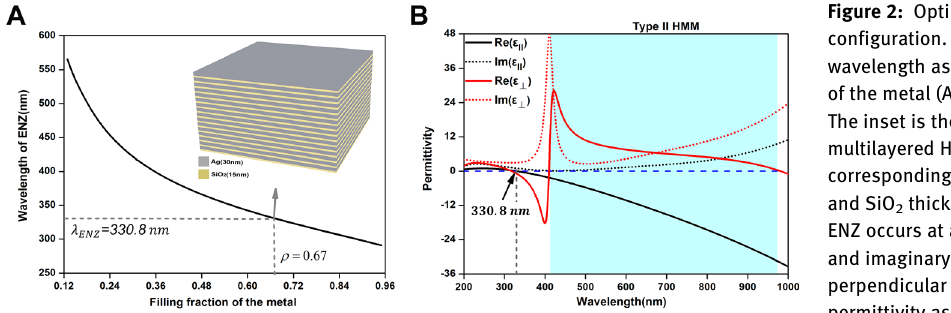
Figure 2: Optical properties of the HMM configuration. (Color online) (A) ENZ wavelength as a function of filling fraction of the metal (Ag) versus dielectric (SiO 2 ).